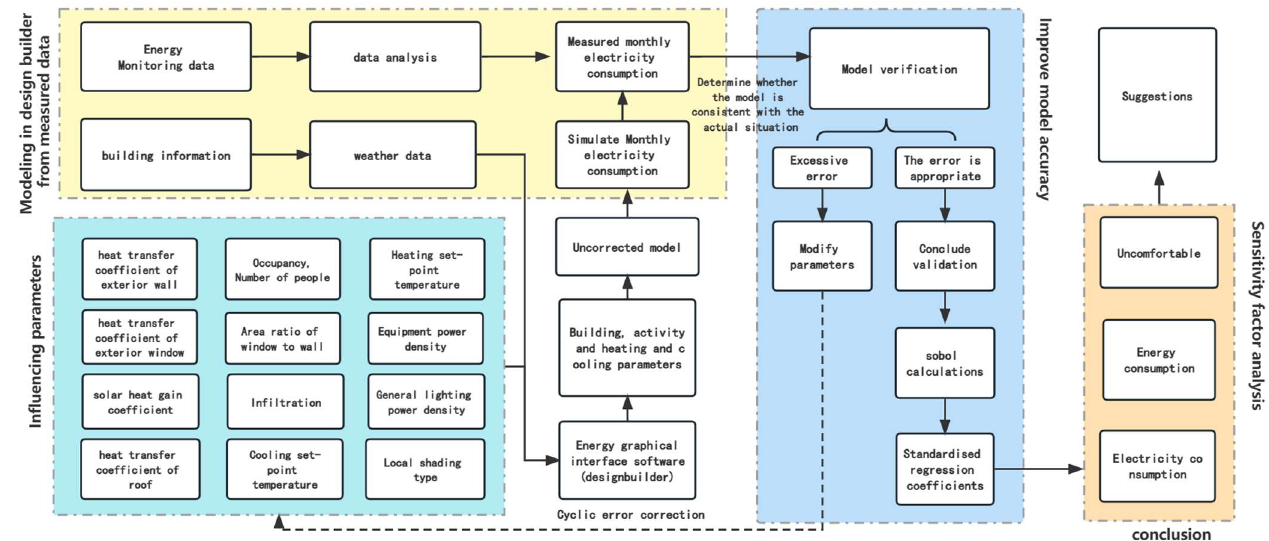
Figure 1. Research